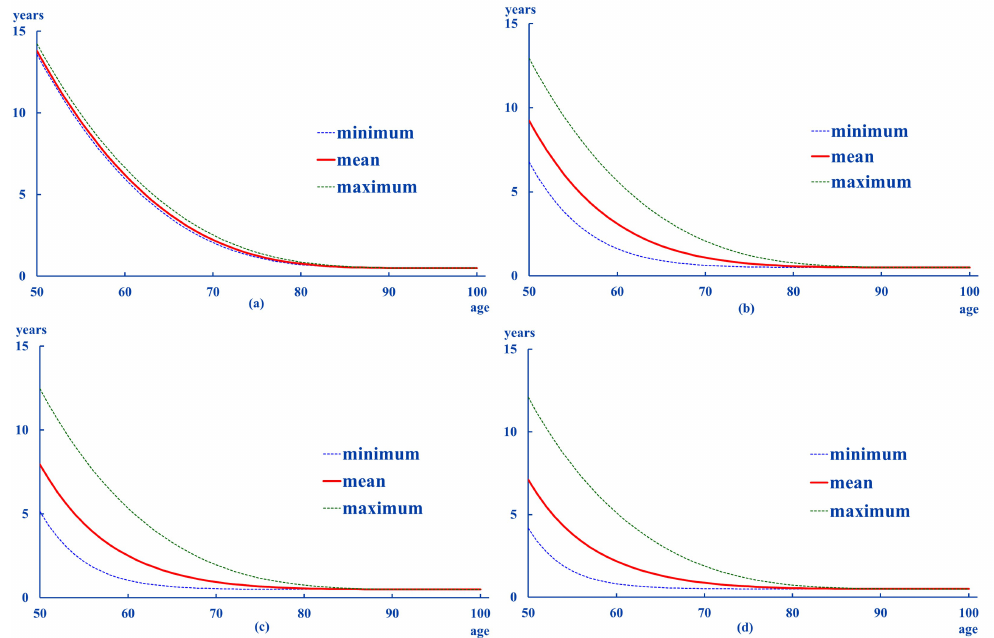
Figure 2. e x : men. ( a ): Degree 0, ( b ): Degree I, ( c ): Degree II, ( d ): Degree III.